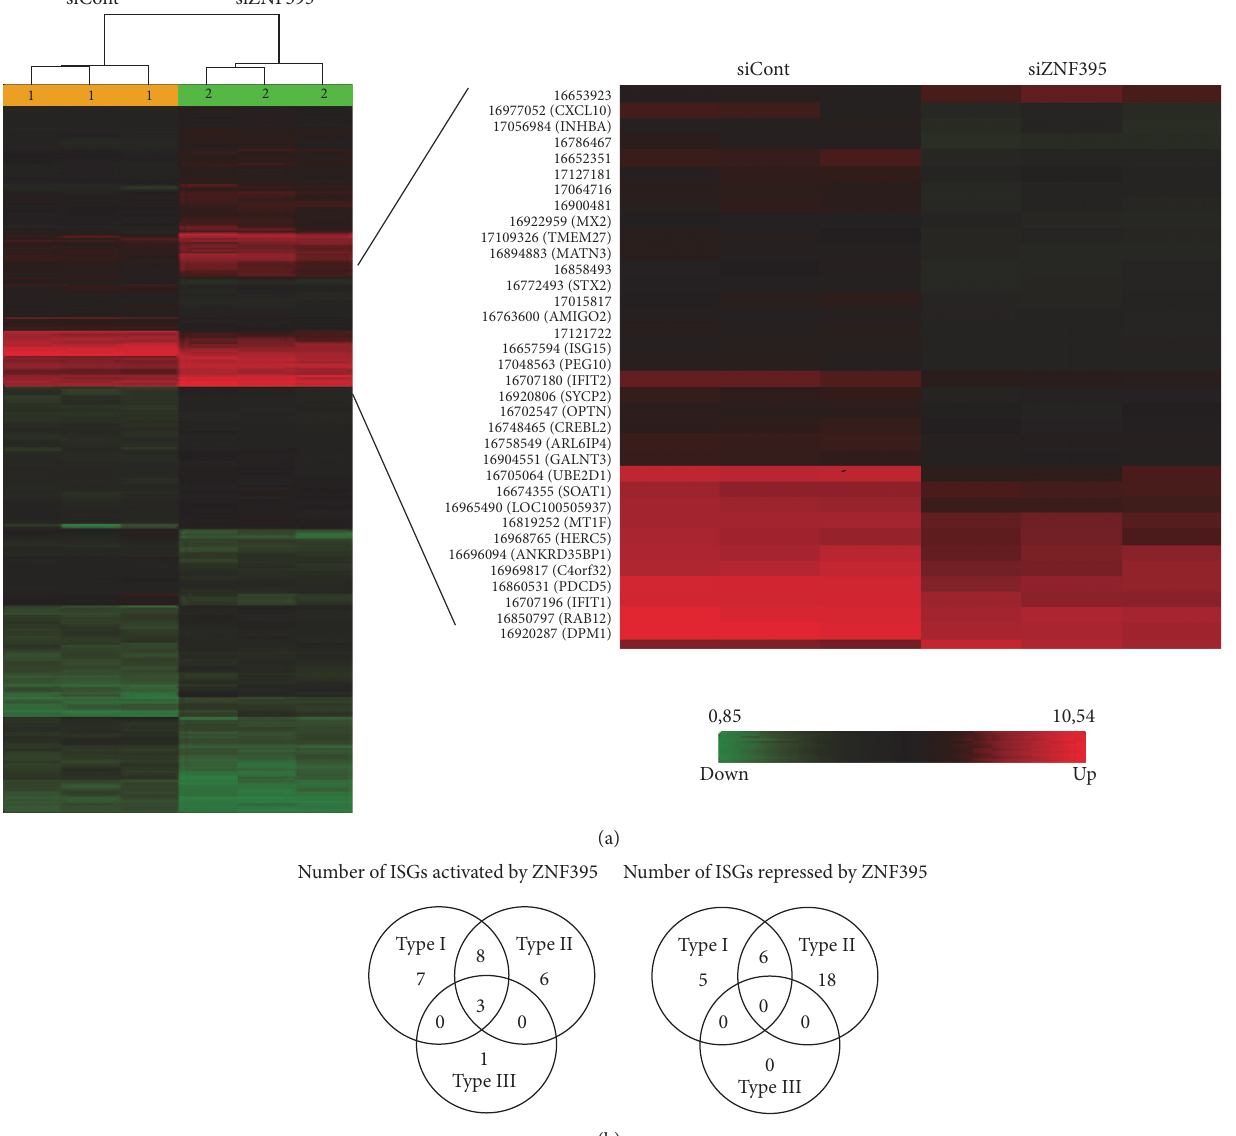
Figure 1: ZNF395 affects IFN 𝛼 -mediated gene expression in keratinocytes. (a) Hierarchical clustering of transcriptome analysis of IFN 𝛼 treated RTS3b cells, transfected with pooled siRNAs against ZNF395 (2, right) or control siRNA (1, left) in triplicate, using Affymetrix Hu GeneChips.Thegeneclustersareshownontheright.Intotal,156genesweredifferentiallyexpressed( 𝑛 > 2 -fold, 𝑝 < 0.01 ).(b)Venndiagram. Among the differentially expressed genes 54 were IFN-regulated genes, with 25 genes being upregulated and 29 genes being repressed by ZNF395. The Venn diagram shows the number of type I, type II, and type III interferon regulated genes that are affected by ZNF395 in IFN 𝛼 treated RTS3b cells, as proposed by the Interferome